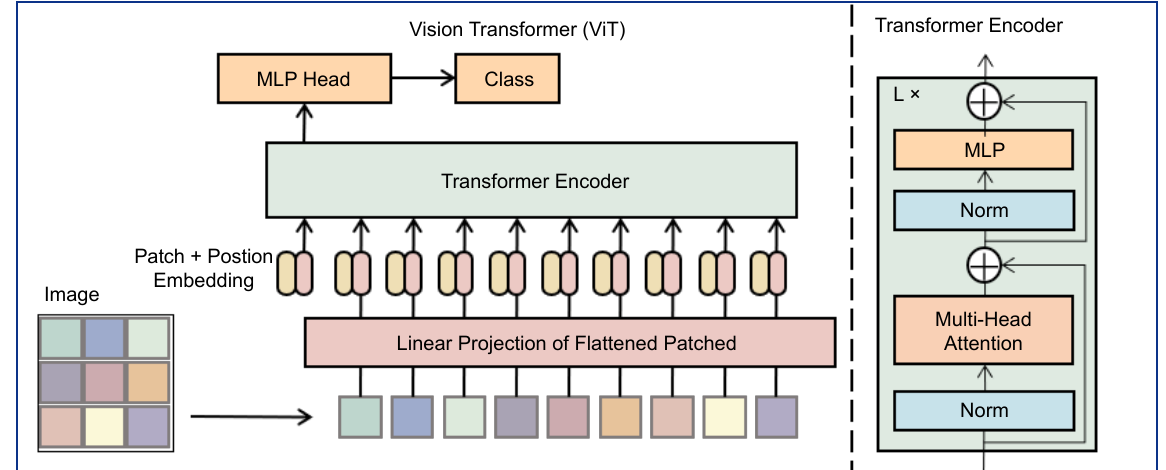
Figure 4 The architecture of vision transformer